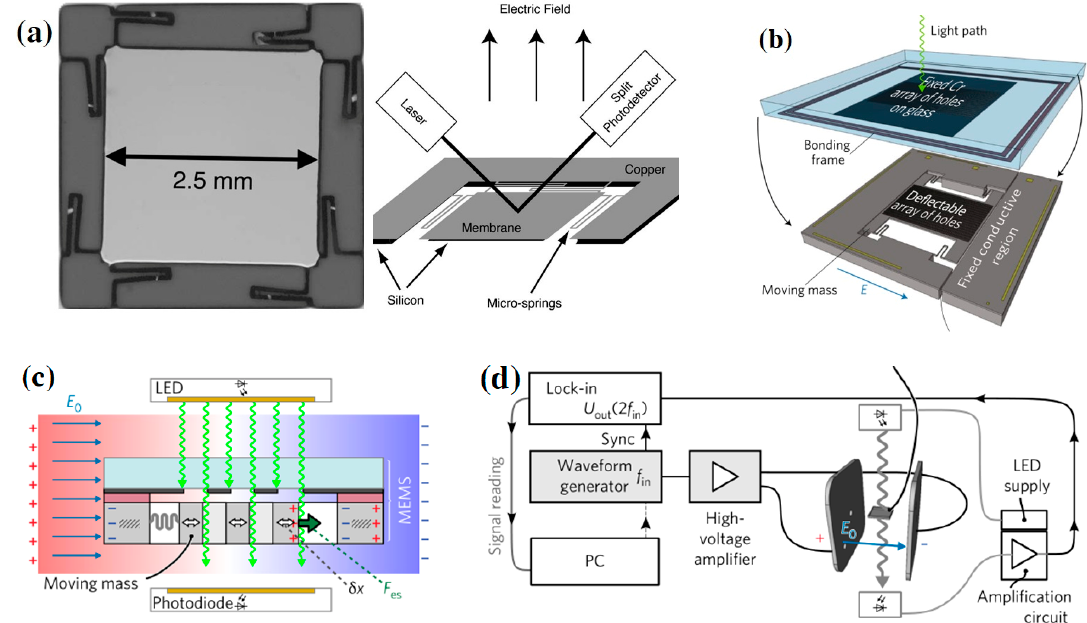
Figure 17. ( a ) Photograph of micro-spring supported copper membrane and the schematic of operating principle [113], ( b – d ) MEMS chip, working mechanism and the sensing system [114]; permission conveyed through the Copyright Clearance Center, Inc.